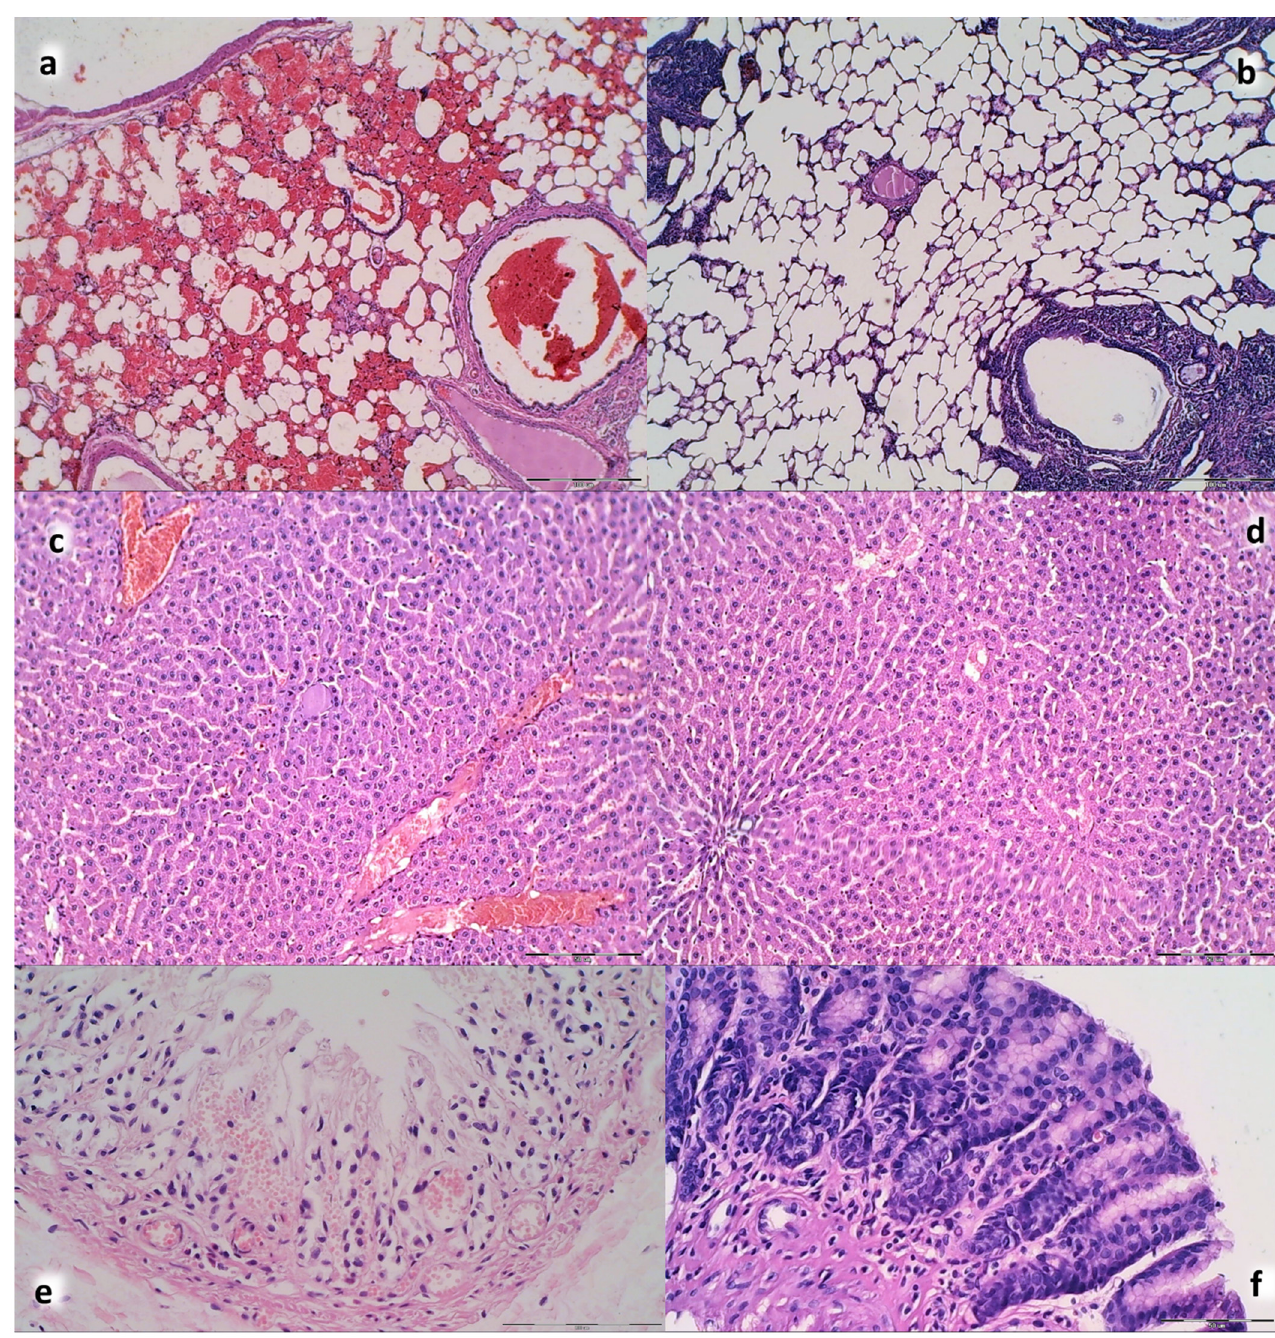
Figure 15. Illustrative microscopic presentation of the lung ( a ) (control), ( b ) (BPC 157)), liver ( c ) (control), ( d ) (BPC 157)), and stomach ( e ) (control), ( f ) (BPC 157)) (HE staining. ( a – d ) Presentation at the 20 min ligation-time, 5 min after saline ( a , c ) or BPC 157 ( b , d ) intragastric application. ( a ) Control rats with congestion and intralveolar hemorrhage; ( b ) no congestion and lung hemorrhage in BPC 157 rats; ( c ) liver parenchyma showed congestion in control; ( d ) BPC 157 rats showed no changes in liver parenchyma; ( e , f ) presentation at the 24 h ligation-time, saline or BPC 157 at 1 min ligation-time; ( e ) controls with erosive gastritis; ( f ) BPC 157 rats with no pathological changes. Magnification ×100 (( a , b ) scale bar 100 µm), ×100 (( c , d ) scale bar 50 µm), ×200 (( e ) scale bar 100 µm), ×200 (( f ) scale bar 50 µm).